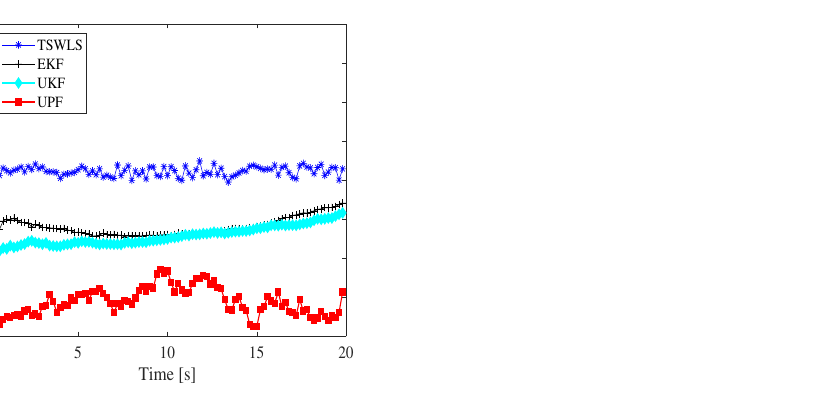
Figure 6. The RMSE of different algorithms in NLOS scenario ( σ θ